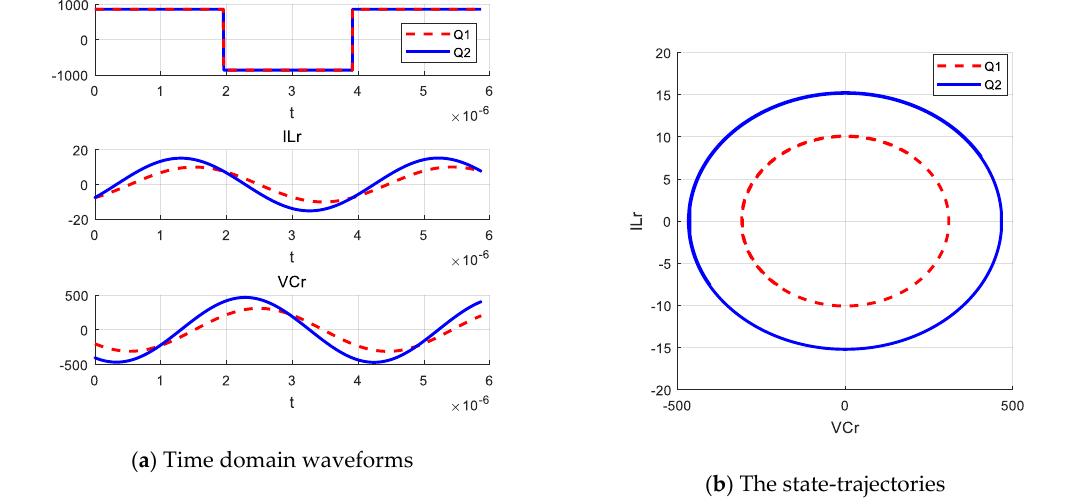
Figure 5. MATLAB calculation results at resonant frequency.